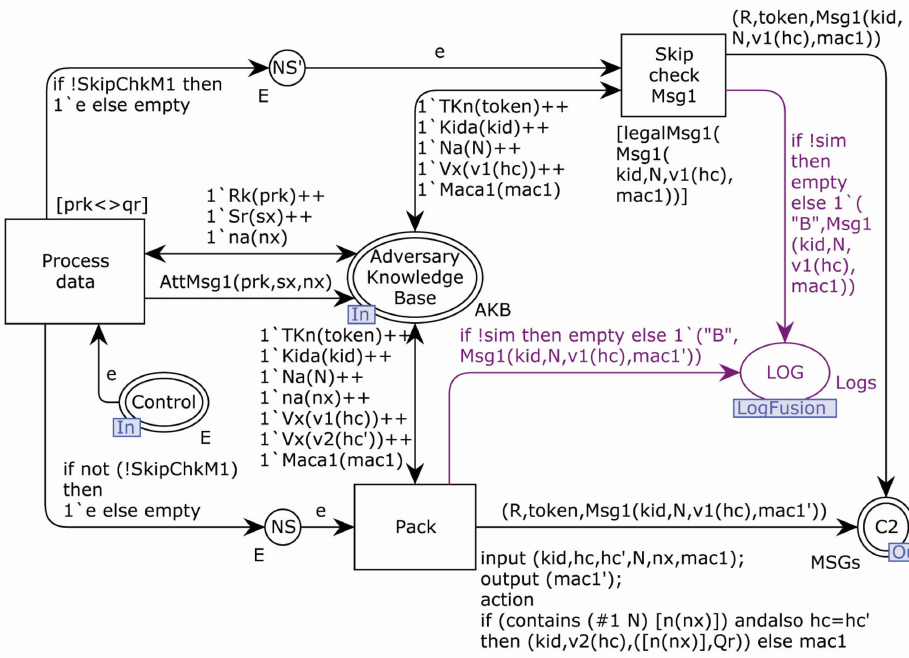
Figure 14. Adversary model sub-page